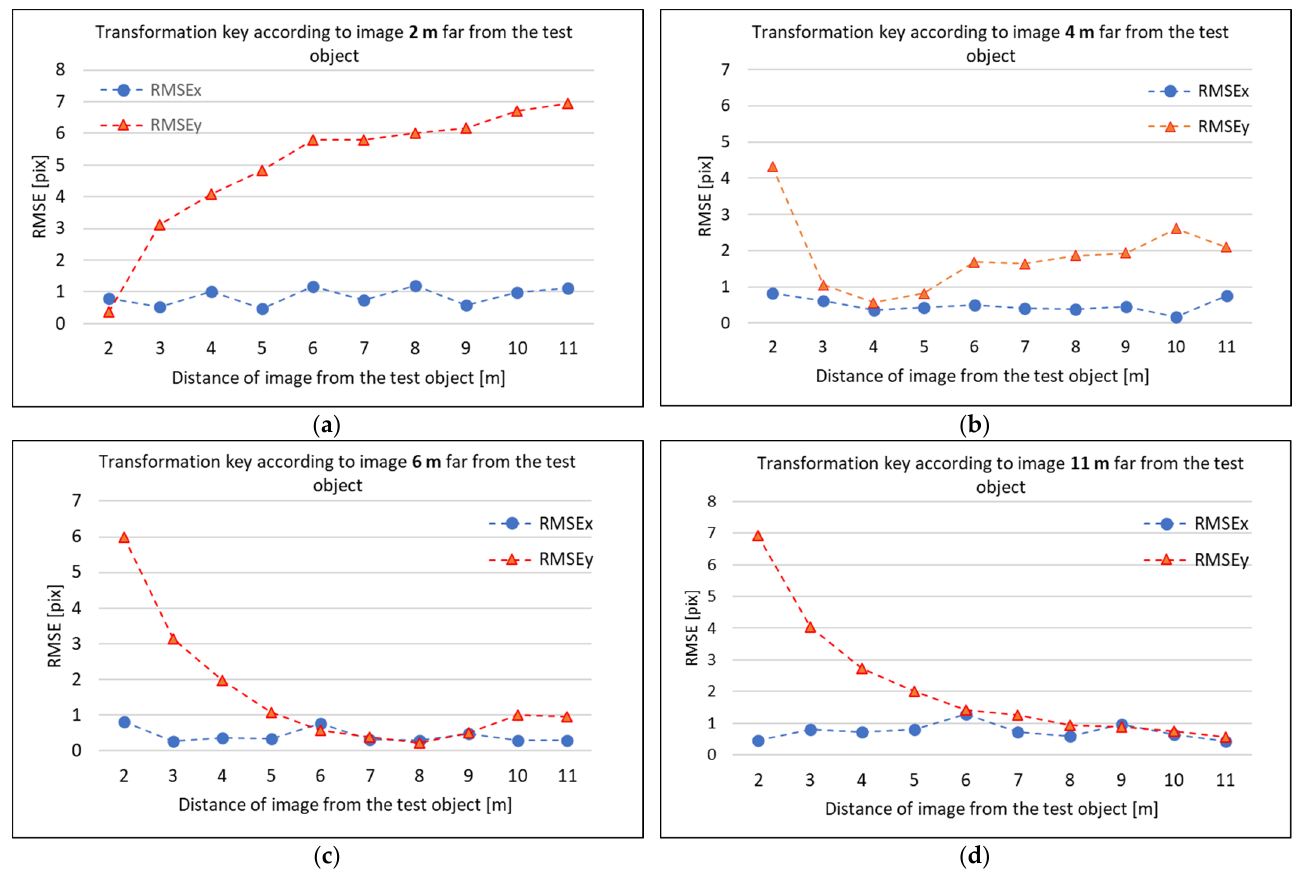
Figure 5. RMSEx and RMSEy of residuals on the TIR image transformed to the RGB image using affine transformation: ( a ) transformation key computed on 2 m image-pair; ( b ) transformation key computed on 4 m image-pair; ( c ) transformation key computed on 6 m image-pair; ( d ) transformation key computed on 11 m image-pair.